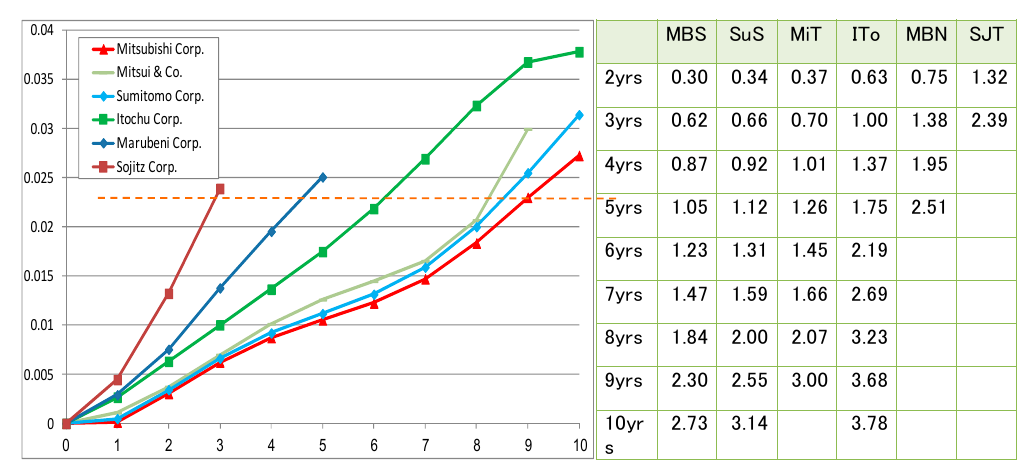
(cid:8) (cid:9) p s t =  for each p t ( s ) : t = 1,2, ··· ,48 for each t p s t =  for each t